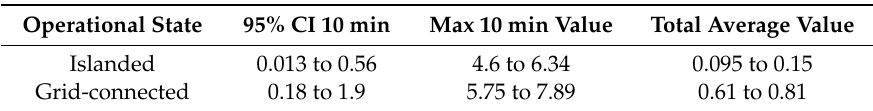
Table 6. 95% confidence interval, the maximum 10 min value and total average value for all three Table 7 . 95% confidence interval, the maximum 3 s value and total average value for all three phases phases in islanded and grid-connected in islanded and grid-connected operation.